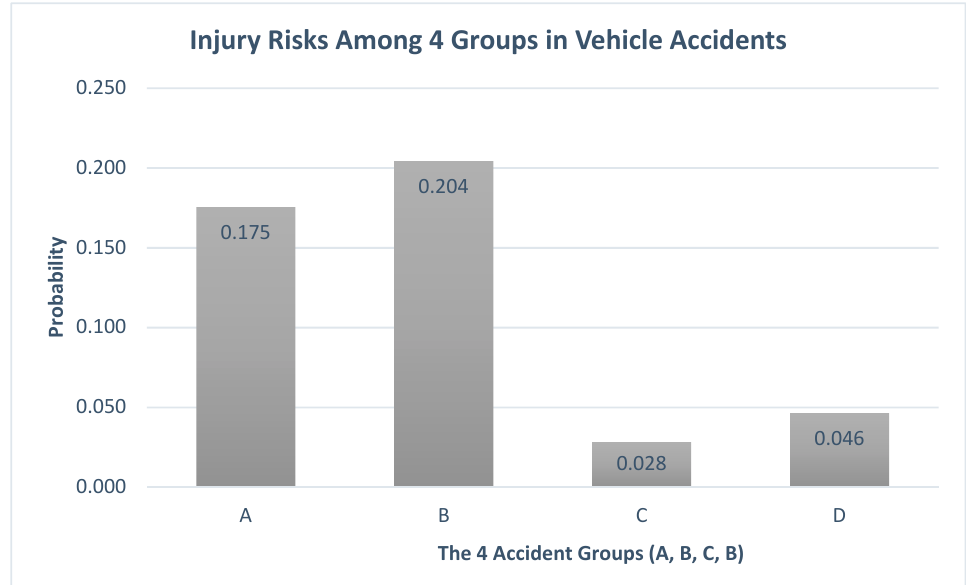
Figure 1. Probability (risk or chance of injury) versus the 4 Accident Groups (A, B, C, D).